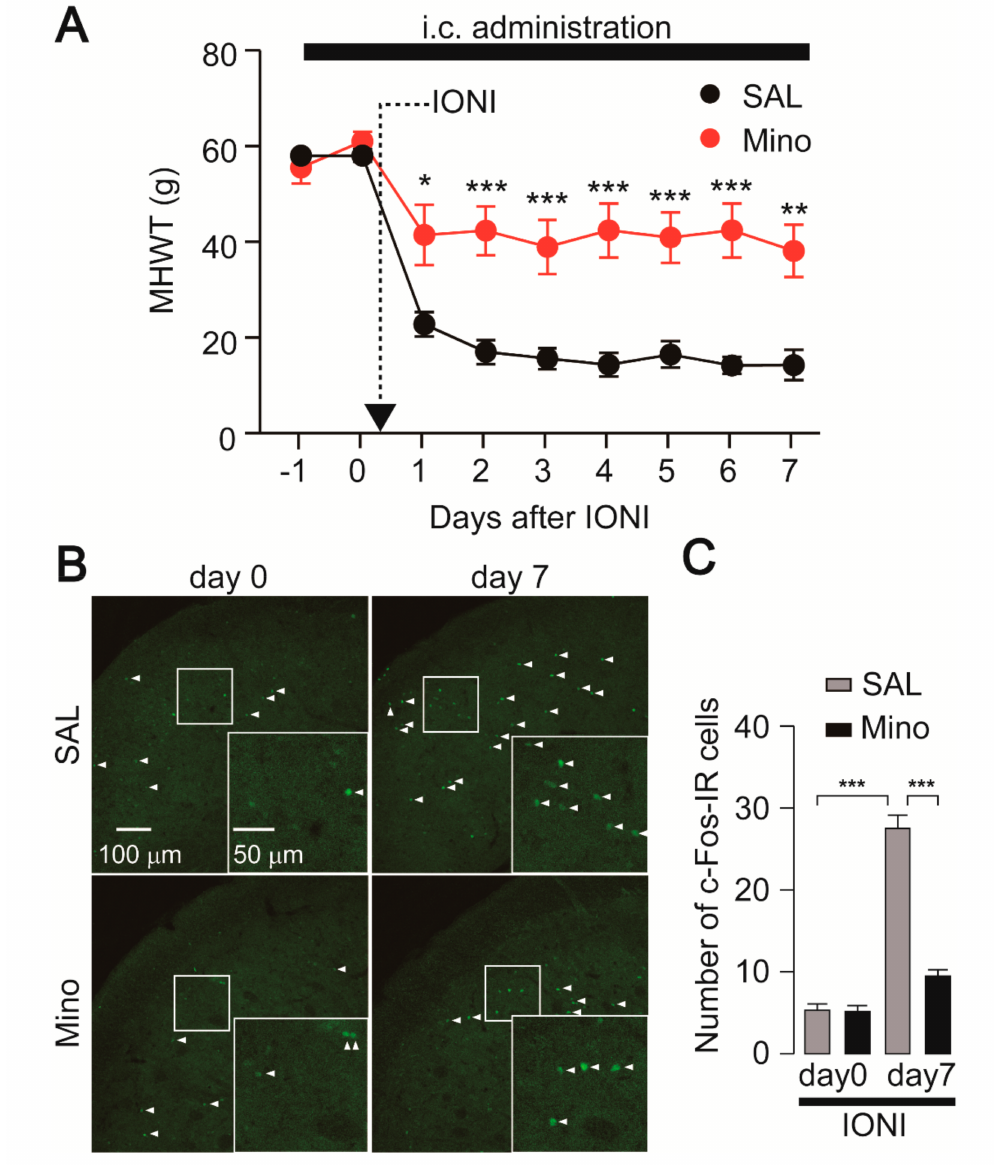
Figure 1. Minocycline inhibits the development of mechanical hypersensitivity in whisker pad skin and reduces c-Fos expression in the Vc following infraorbital nerve injury (IONI). ( A ) Time-course of mechanical head withdrawal threshold (MHWT) applying a von Frey filament to the whisker pad skin. SAL: n = 7, Mino: n = 10, two-way ANOVA post hoc Bonferroni test, * p < 0.05, ** p < 0.01, *** p < 0.001 (vs. SAL-treated group). SAL and Mino indicate saline and minocycline, respectively. Black bar indicates the period treated saline or minocycline. ( B ) Representative images of c-Fos immunofluorescence in the Vc 0 and 7 days after IONI. Insets indicate enlarged images of the region indicated in the open square. Arrowheads indicate c-Fos-IR cells. ( C ) The average number of c-Fos-IR cells in the Vc of saline or minocycline-treated rats 0 and 7 days after IONI. SAL (day 0): n = 5, Mino (day 0): n = 5, SAL (day 7): n = 7, Mino (day 7): n = 10, two-way ANOVA followed by Tukey’s multiple comparison test, *** p < 0.001. The data represent the means ±